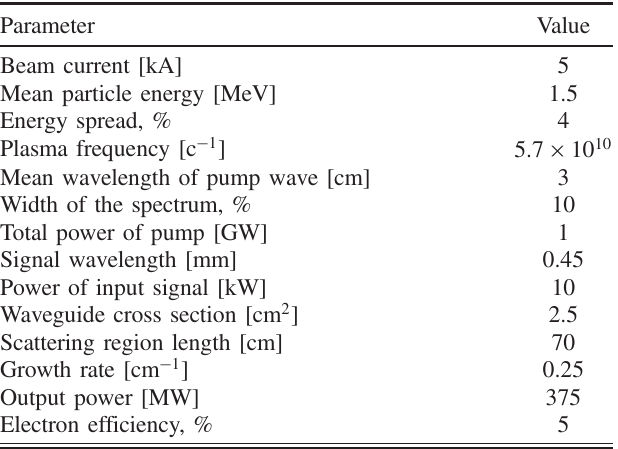
TABLE I. Main parameters of the high-gain single-pass